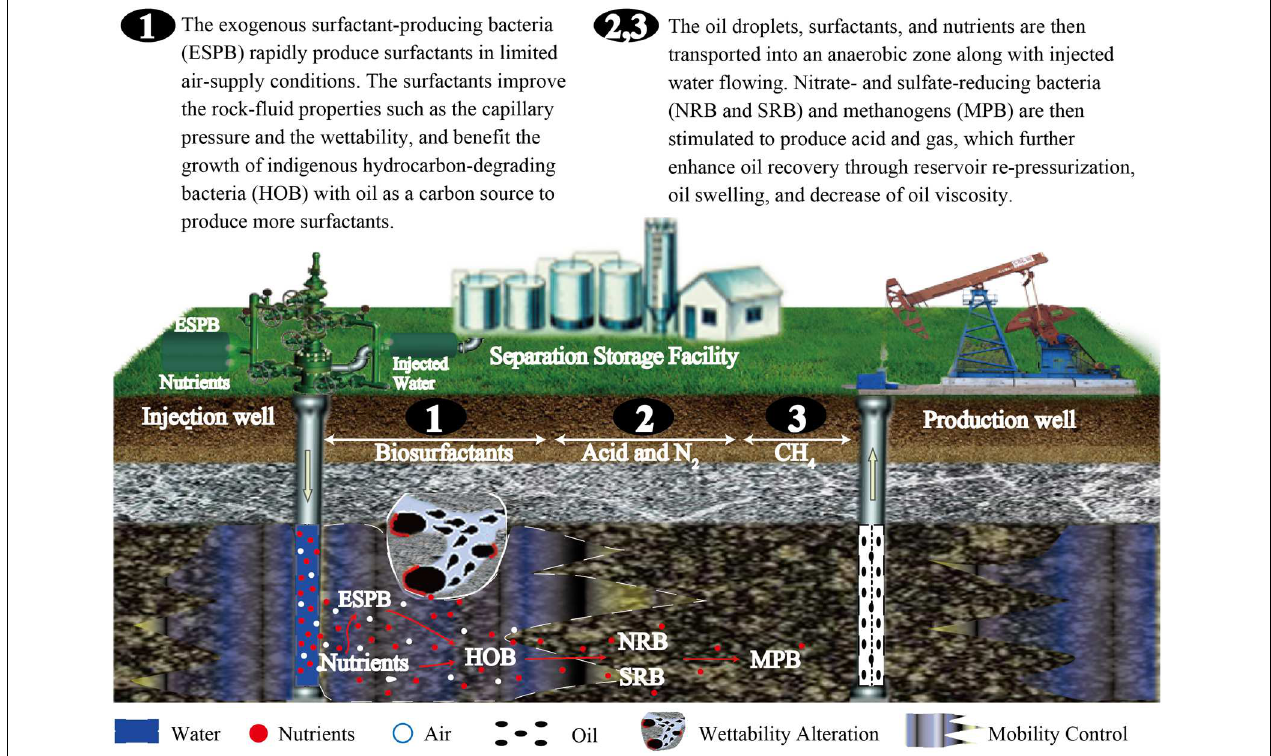
FIGURE 1 | Schematic showing how exogenous surfactant-producing bacteria facilitate indigenous microbial enhanced oil